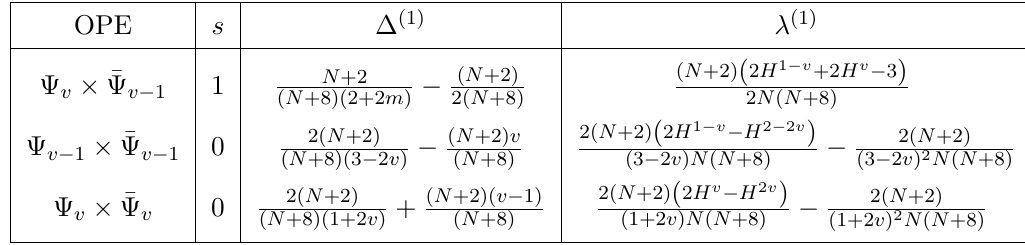
Table 2. The ε -expansion results for various operators, m = 0